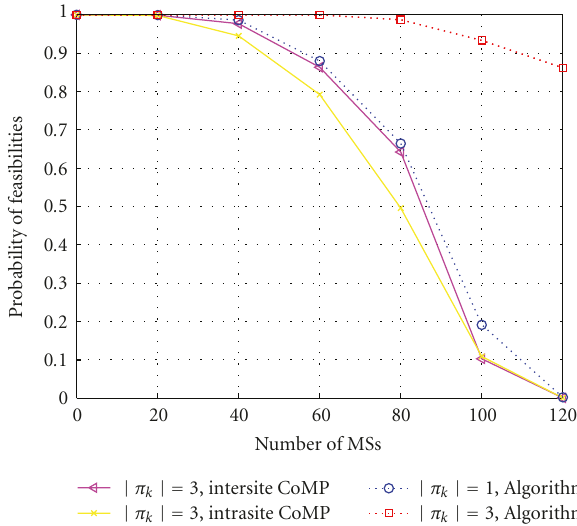
Figure 7: Comparison of probabilities of feasibility of intra-site, inter-site cooperation and proposed adaptive reception schemes. Again SINR constraint is 0dB.